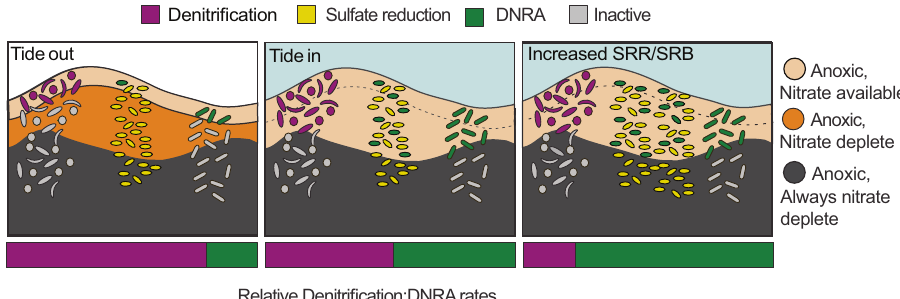
Fig. 8 In fl uence of changing boundary conditions on process rates Schematic outlining the changes in microbial activity over a tidal cycle (left and middle panels) and in a case where sulfate reducing bacteria become more abundant (right panel). When the tide is out, only the upper surface of the sediment has nitrate, and nitrogen reduction is dominated by denitri fi cation. When the tide is in, nitrate reaches deeper into the surface and correspondingly to more sulfate reducers, which switch their metabolism to DNRA. This results in a more even denitri fi cation:DNRA ratio. In sediments with more sulfate reducers, it is expected that DNRA rates would also increase as some sulfate reducers perform DNRA. For simplicity, oxygen dynamics are